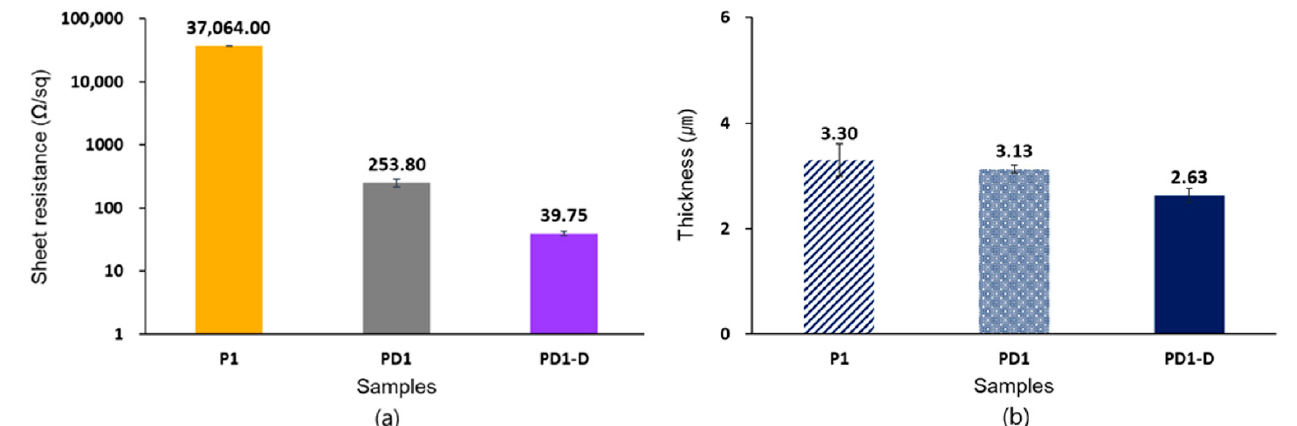
Figure 4. Changes in ( a ) electrical sheet resistance in the logarithmic scale and ( b ) thickness of sample P1, PD1, and PD1-D as the solvent treatment step. Table 4. Linear regression equations of the samples.